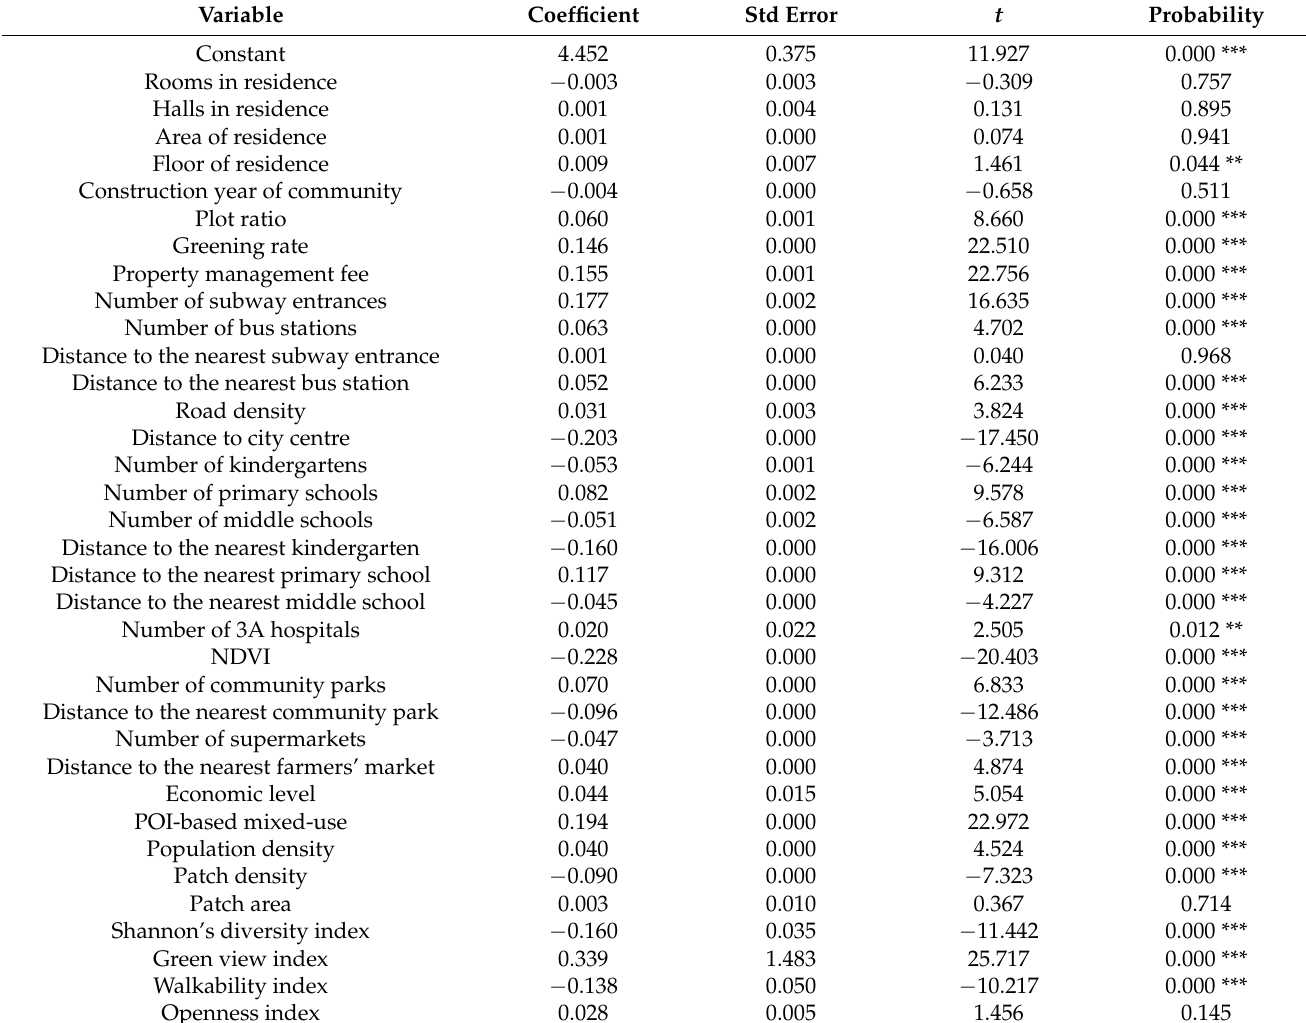
Table 3. The estimated coefficients of the